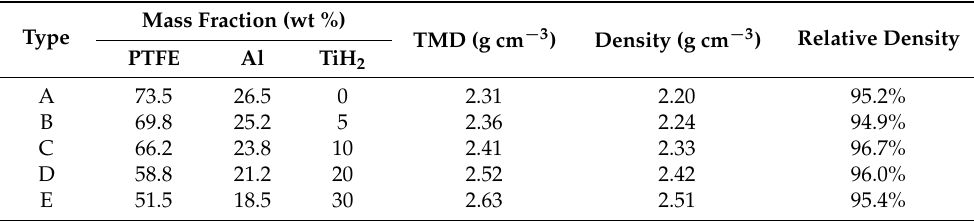
Table 1. Components and theoretical material density (TMD) of the polytetrafluoroethylene (PTFE)/Al/TiH 2 granular composites.